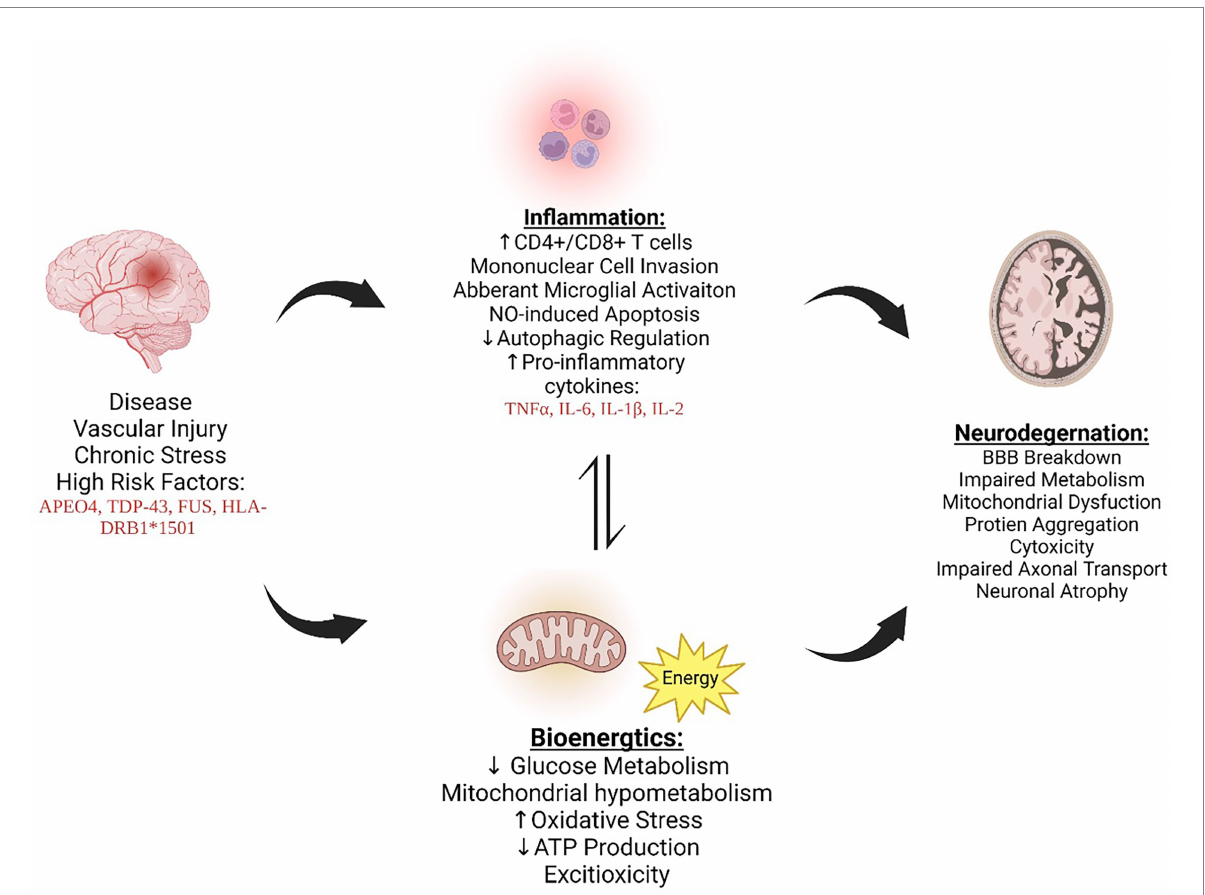
FIGURE 1 AD, MS, and ALS exhibit increased inflammation and bioenergetic changes, ultimately leading to neurodegeneration and furthering disease progression. The cross talk between inflammation and bioenergic dysfunction is dynamic and influences one another, promoting dysregulation. Figure created with BioRender.com